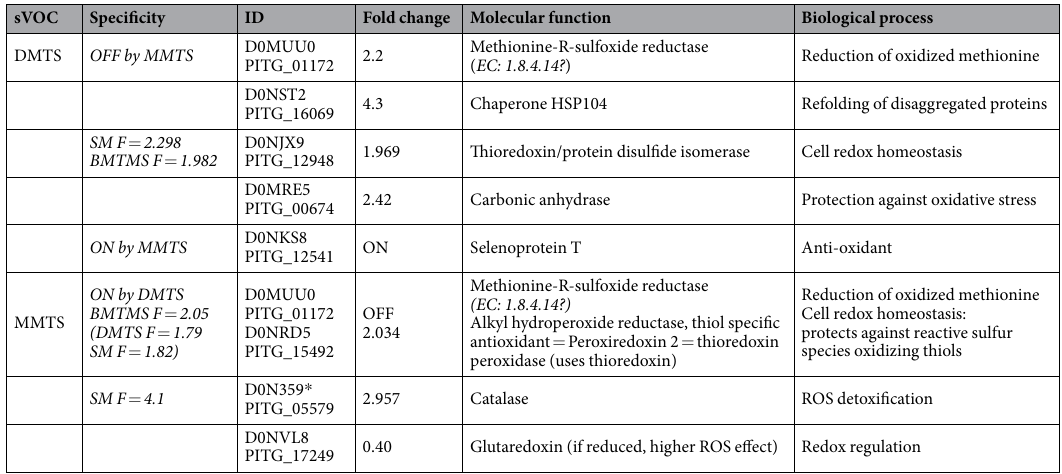
ON by DMTS BMTMS F = 2.05 MMTS